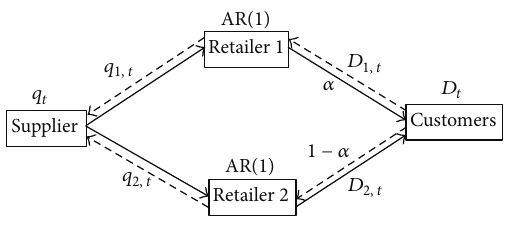
Figure 1: Supply chain